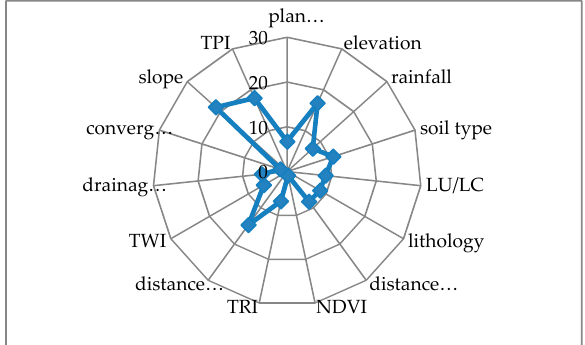
Figure 5. Relative importance of gully erosion conditioning factors using the random forest model.